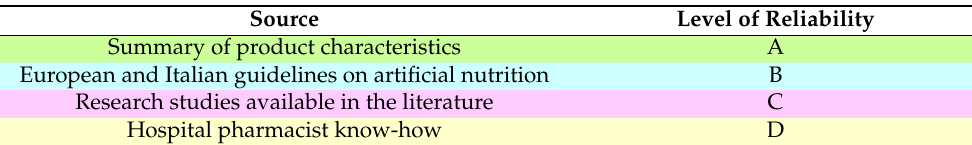
Table 1. Sources chosen to evaluate the suitability of drug administration via tube and their level of reliability in decreasing order. The sources of the information are highlighted in different colors according to their level of reliability. Green, level A (SmPC); light blue, level B (Guidelines); pink, level C (literature); yellow, level D (pharmacist